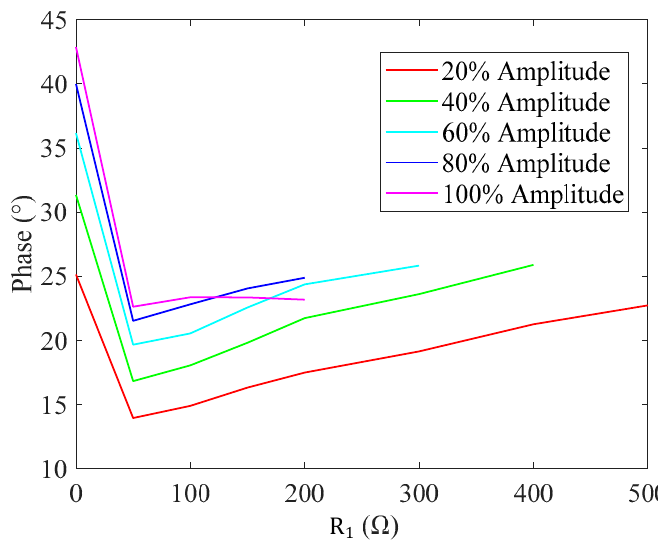
Figure 14. Phase deviation under different loads and vibration amplitudes.